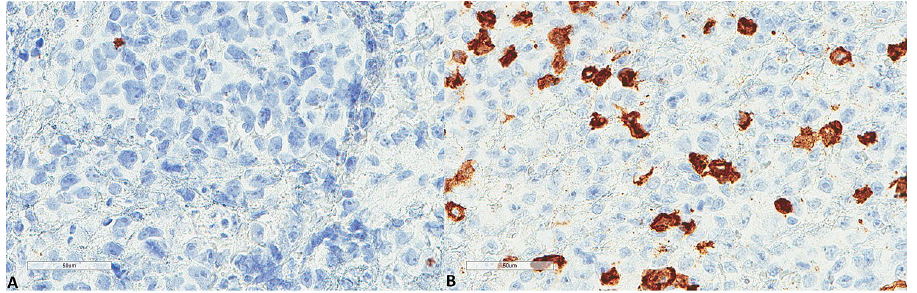
Figure 9. Representative images of CD8 expression. ( A ) Lower expression in a patient diagnosed with PCNSL MSKCC B group (× 400). ( B ) Higher expression in a patient diagnosed with PCNSL MSKCC C group (×